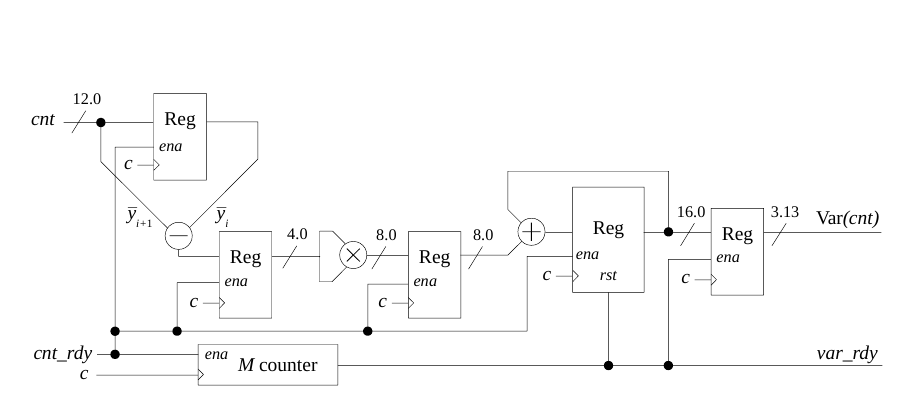
Figure 10: Allan variance measurement circuitry based on Eq. (13)